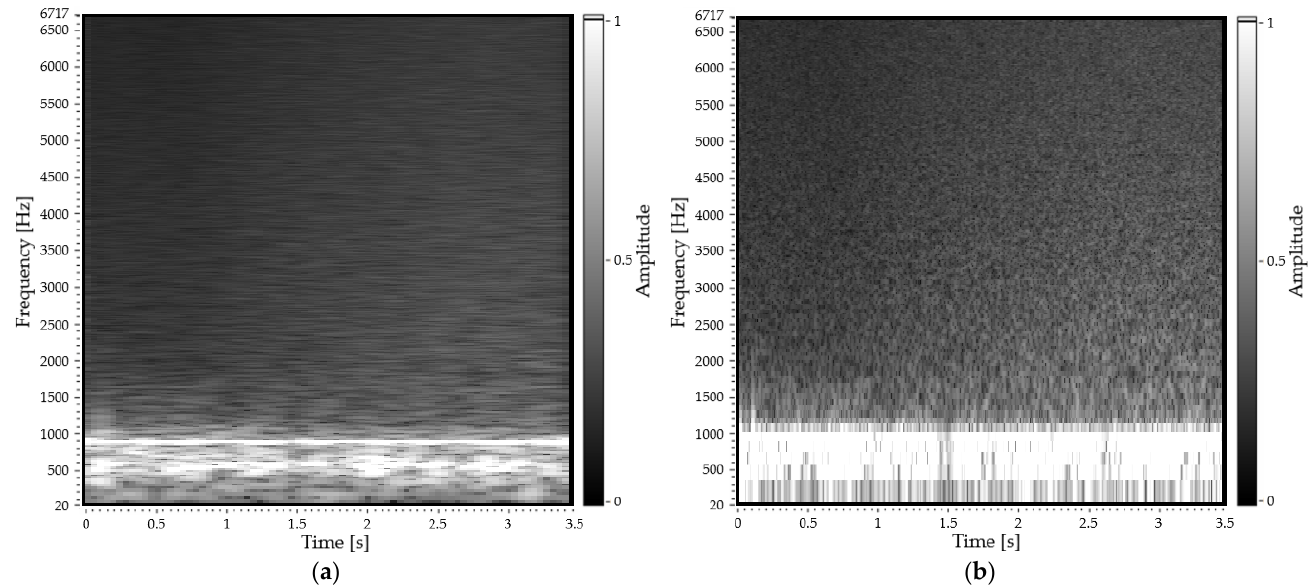
Figure 8. A sample of spectrogram 1 ( a ) and spectrogram 2 ( b ), where intensity of EN is increased to +10 dB from the nominal level.